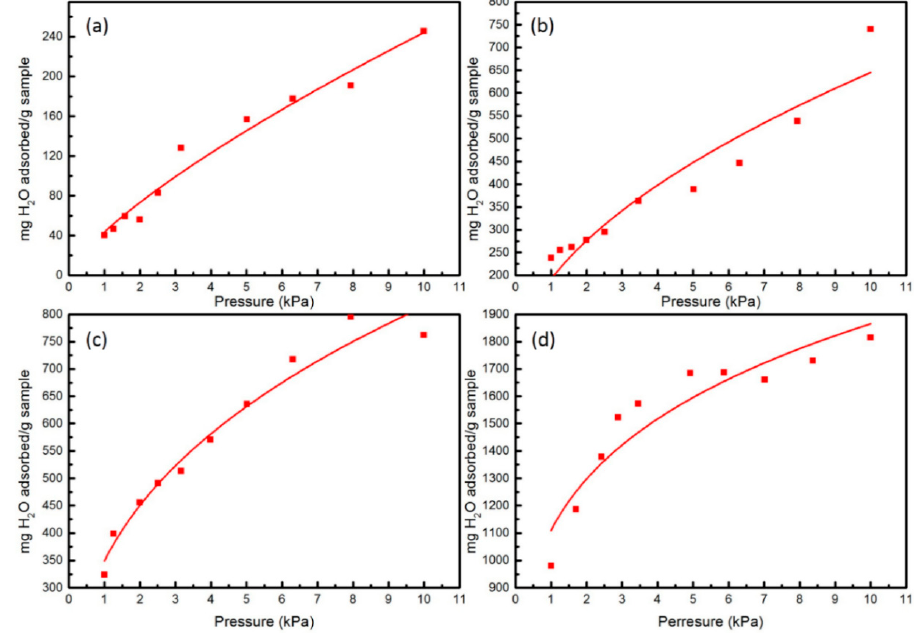
Figure 5. The computed sorption isotherms of H 2 O in ( a ) EB-PANI; ( b ) Na-SPANI (I); ( c ) Na-SPANI (II); ( d ) Na-SPANI (III) at 298 K.